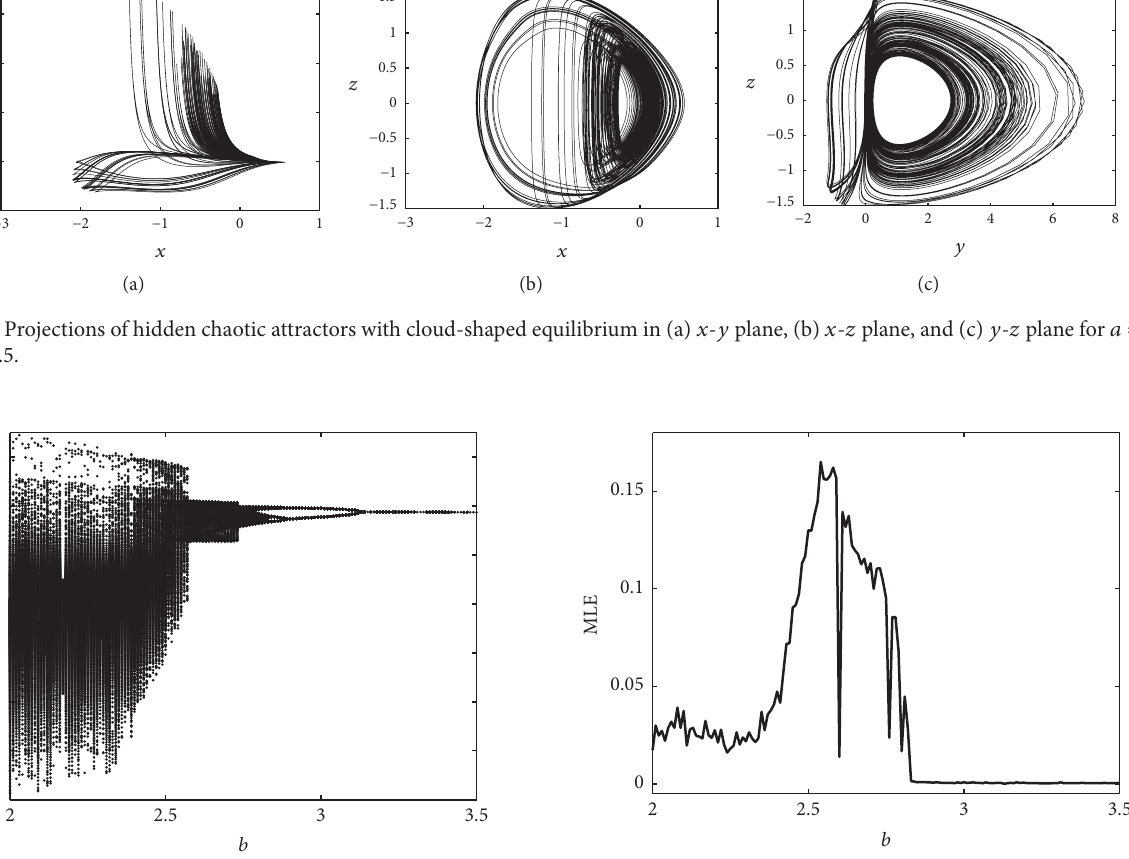
Figure 4: Bifurcation diagram of the system with closed curve equilibrium (9) when decreasing the value of the bifurcation parameter 𝑏 from 3.5 to 2 for 𝑎 = 4 .